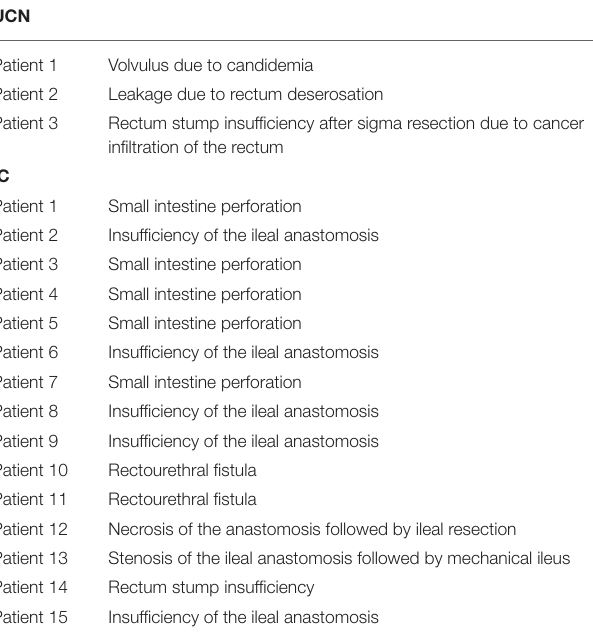
TABLE 2 | Baseline characteristics in octogenarians.